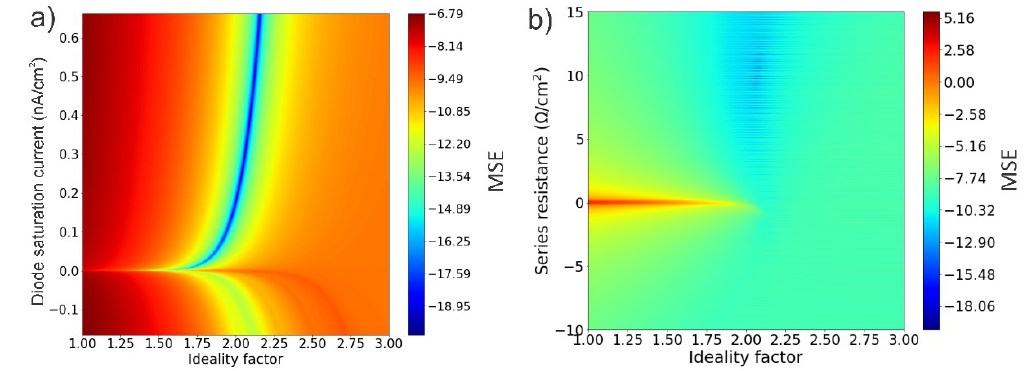
Figure 4. Mean Squared Error (MSE) behavior as function of the estimated parameters for cell 5. MSE as function of ideality factor and diode saturation current ( a ), and MSE as a function of the ideality factor and series resistance ( b ).